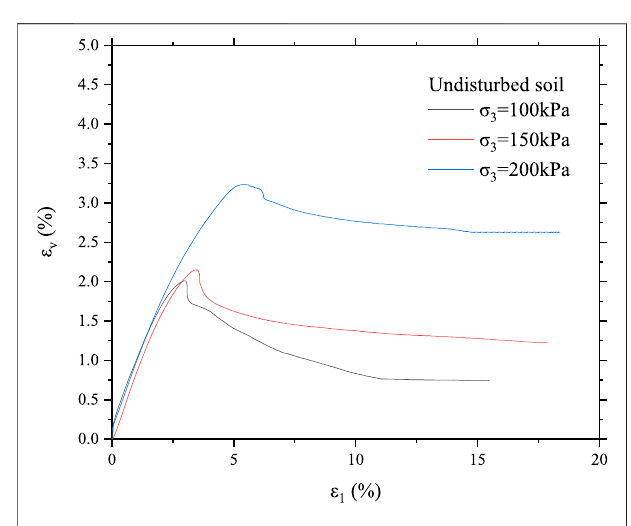
FIGURE 4 | Relation between volumetric strain and axial